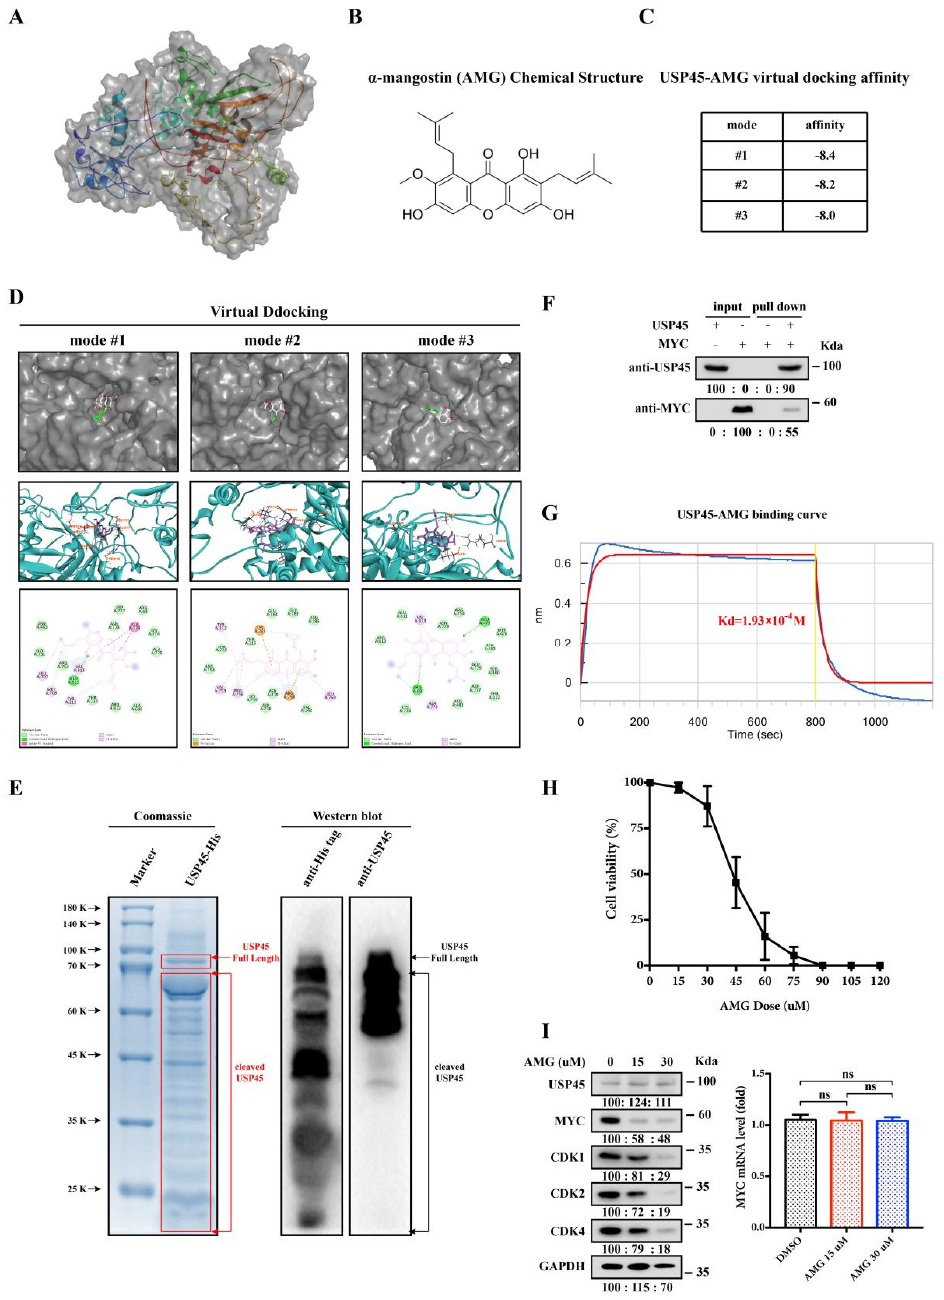
Figure 5. Alpha-mangostin (AMG) may inhibit the deubiquitination-active sites of USP45. ( A ) The structure of USP45 protein was simulated with I-TASSER program. ( B ) AMG chemical structure. ( C ) Top three scores of USP45-AMG virtual docking affinities. ( D ) Interactions between USP45 and AMG: the partial USP45-AMG docking structure (top), 3D diagram (middle) and 2D diagram (bottom) of AMG interaction with the amino acids of USP45. ( E ) USP45 purified from E. coli was analyzed by Coomassie and Western Bolt. ( F ) USP45 purified from E. coli and MYC purified from HEK293T cells were incubated together, followed by pulling down. ( G ) The USP45-AMG affinity was determined using BLI-OCTET K2. ( H ) SiHa cells were treated with different AMG dosages for 48 h, and the cell viability was determined by MTT assay. ( I ) SiHa cells were treated with different dosages of AMG for 48 h and subjected to Western Blot and qPCR analyses, DMSO as the negative control. Experiments were conducted at least two times in duplicates.